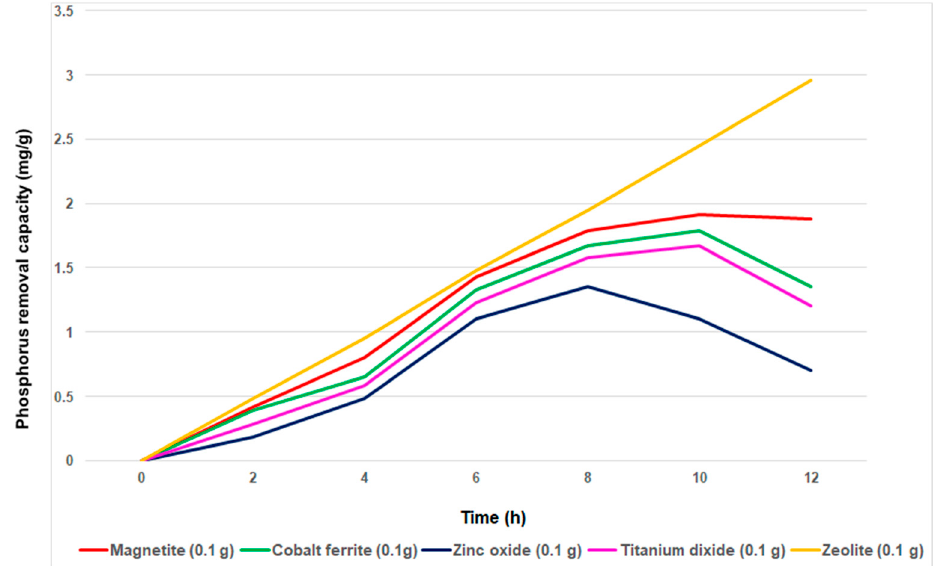
Figure 13. The effect of contacting time on the removal capacity of absorbents.